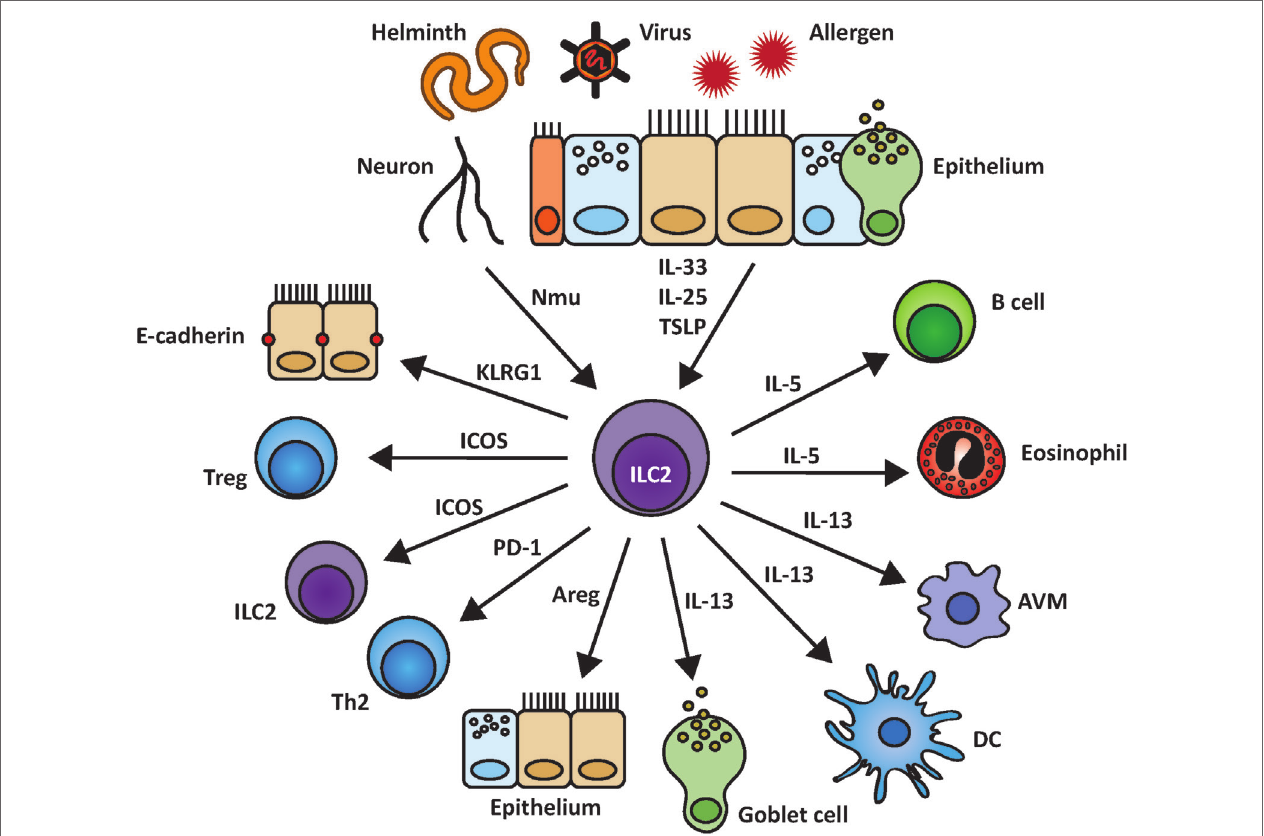
FiGURe 2 | Group 2 innate lymphoid cells (ILC2) and their interactions within the pulmonary environment. ILC2 are induced by epithelial-derived cytokines as well as by other biological mediators such as the neuropeptide neuromedin U (NMU). Upon activation, ILC2 are able to stimulate and communicate with other cell populations by indirect cytokine based or cell–cell mediated interactions including the release of IL-5, IL-13, and amphiregulin (Areg) and binding of KLRG1 to